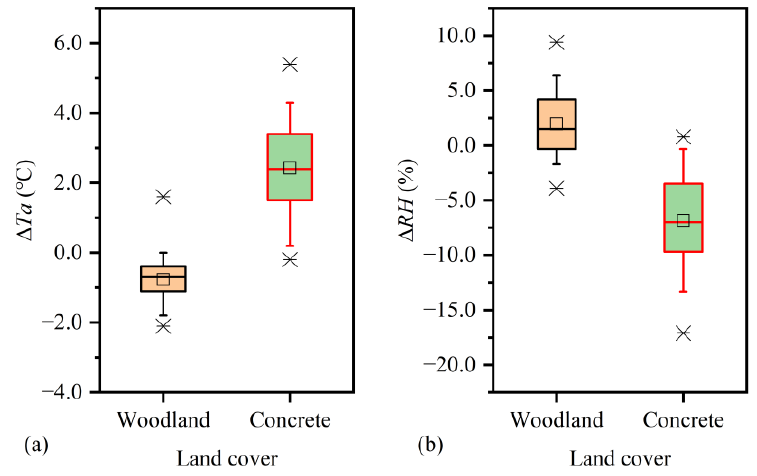
Figure 5. Box plots of Air Temperature Di ff erence ( ∆ Ta ) ( a ) and Relative Humidity Di ff erence ( ∆ RH ) ( b ).